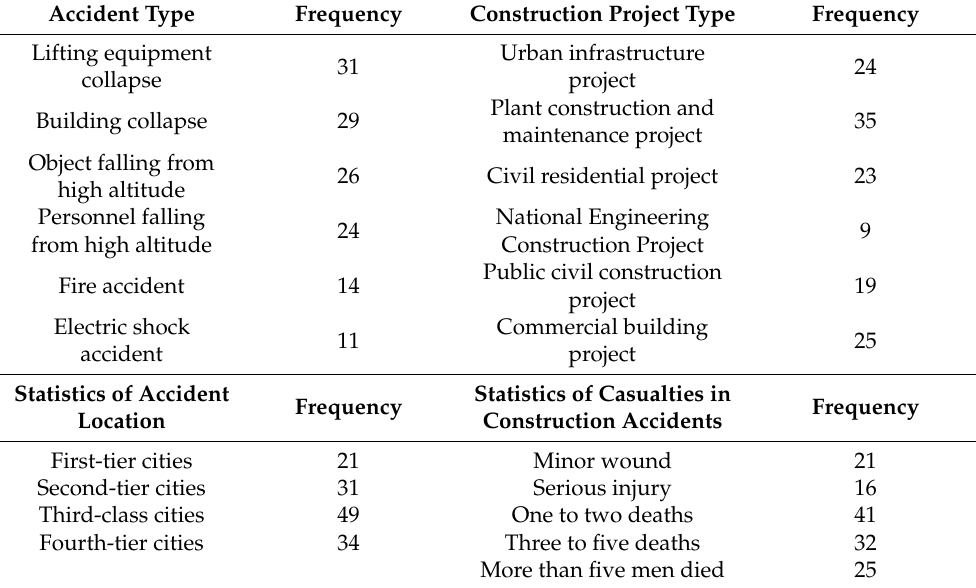
Table 1. Statistical information on collected construction